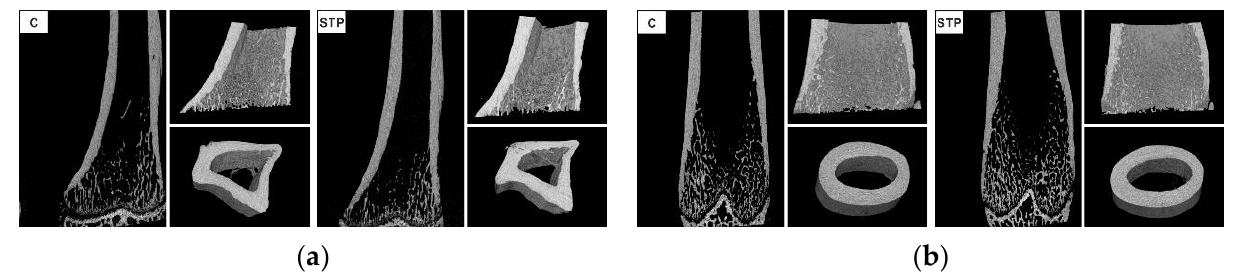
Figure 2. Sample micro X-ray computed tomography images of ( a ) tibia and ( b ) femur (C—control group; STP—group that received stiripentol for 24 weeks).